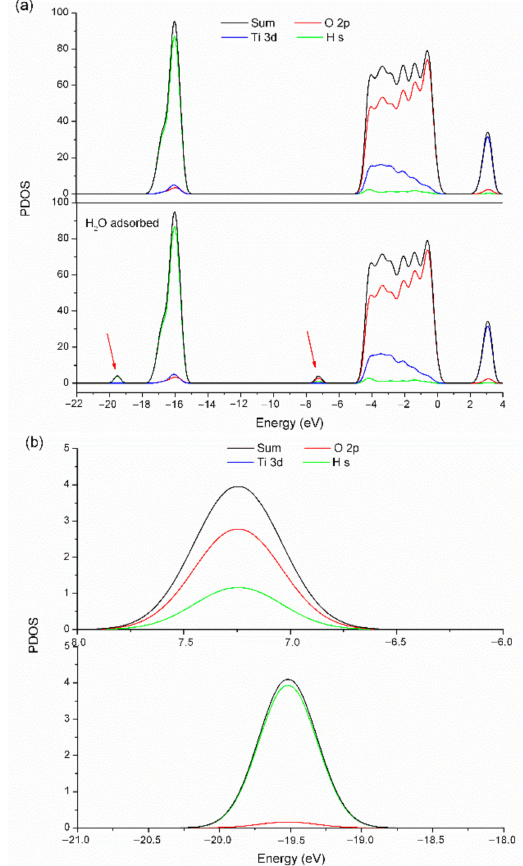
Figure 8. ( a ) Projected density of states of TiO 2 atoms before and after adsorption of water molecules on anatase TiO 2 (101) surfaces and ( b ) local enlargements of projected density of states of TiO 2 atoms after adsorption of water molecules on anatase TiO 2 (101)